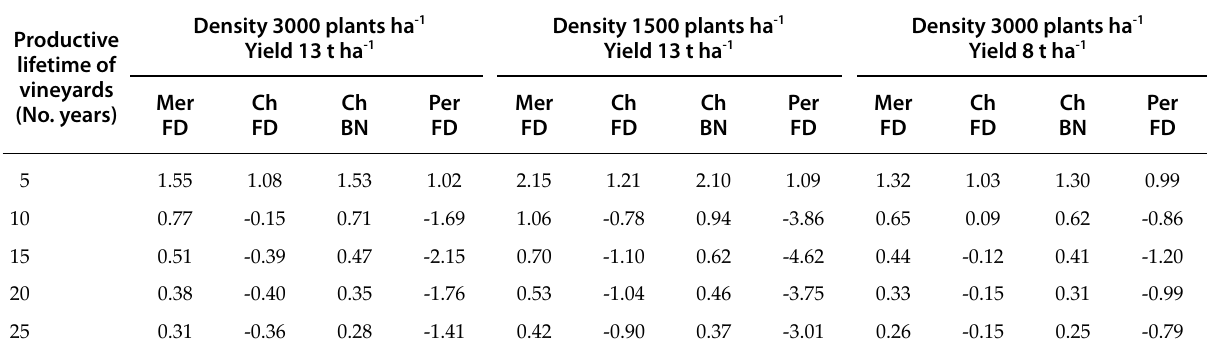
Table 5. Differences between costs of replacement and maintenance “RC-MC” (€/year/plant) estimated for the three grapevine cultivars in relation to different productive lifetimes of vineyards, density of plants per hectare and yield per hectare. Positive and negative values indicate that maintenance involves gain and loss, respectively. Mer = ‘Merlot’; Ch = ‘Chardonnay’; Per =